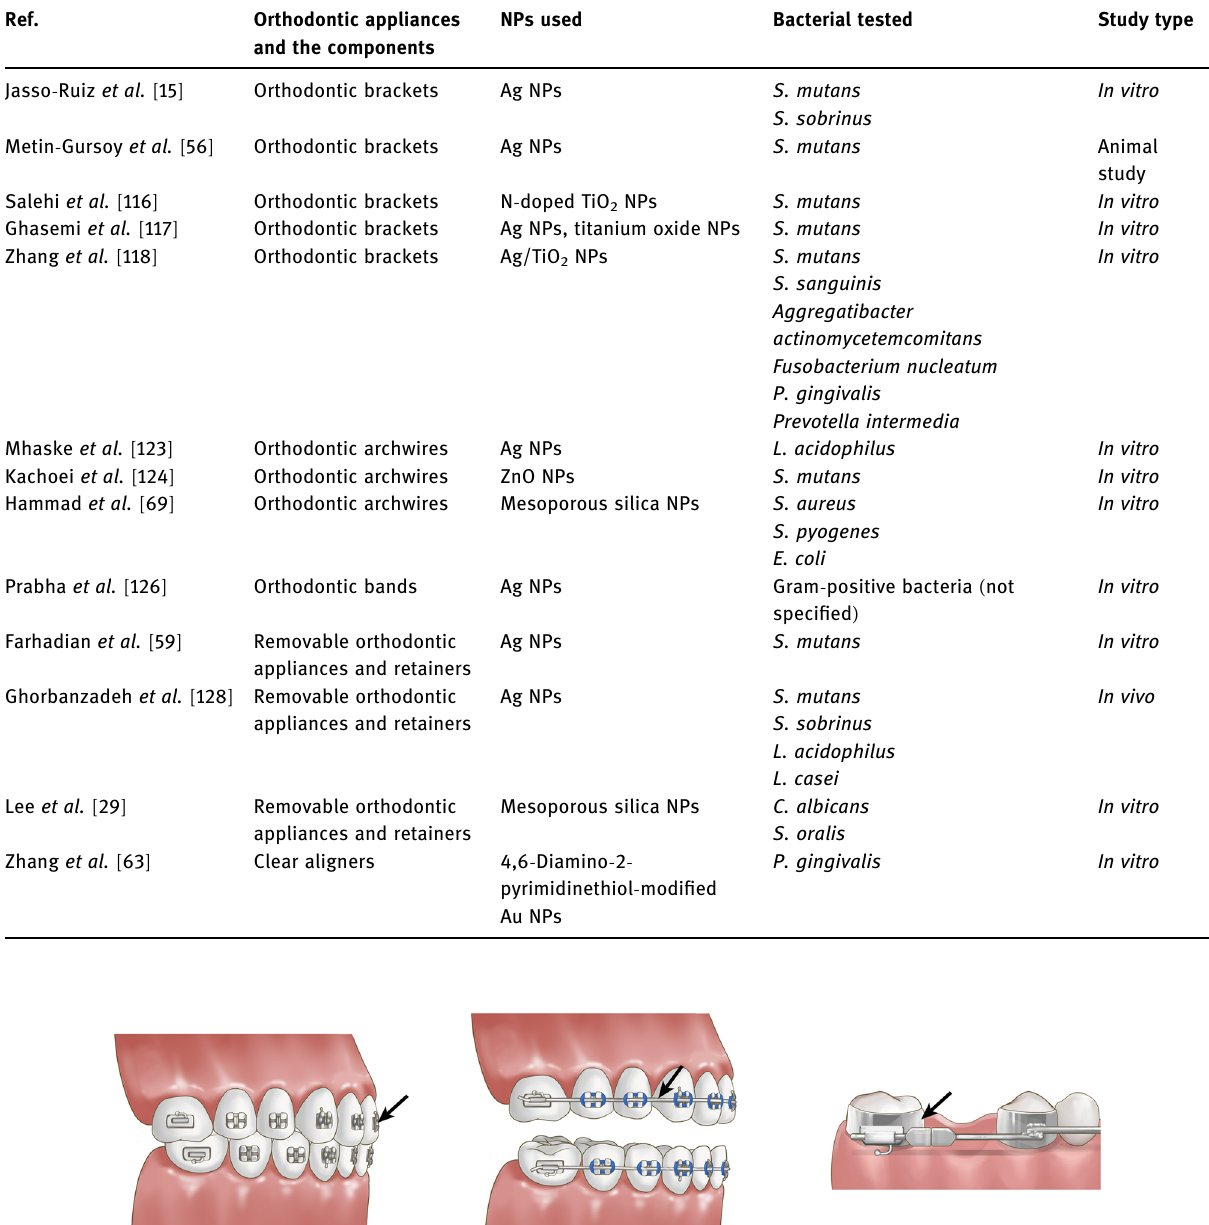
Table 1: Previous antibacterial NPs used in orthodontic appliances and the components Ref.